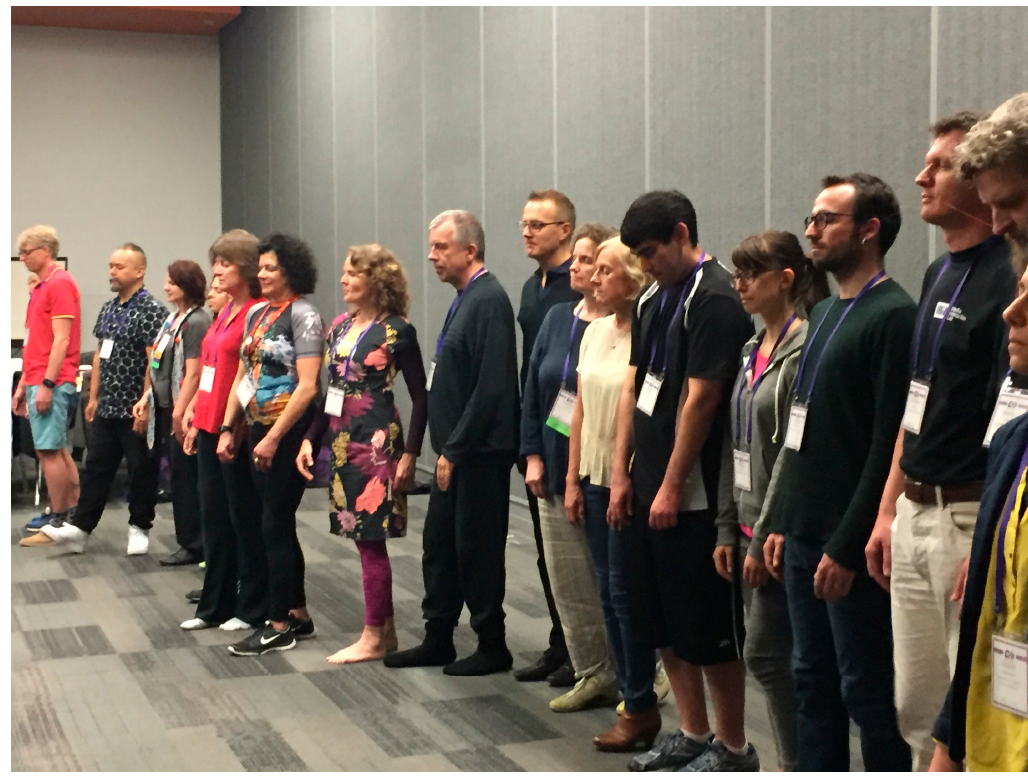
Figure 1. Collaborative Walking at the workshop.